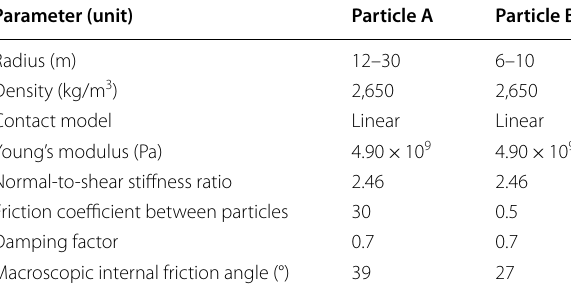
Table 1 Parameters used in the DEM